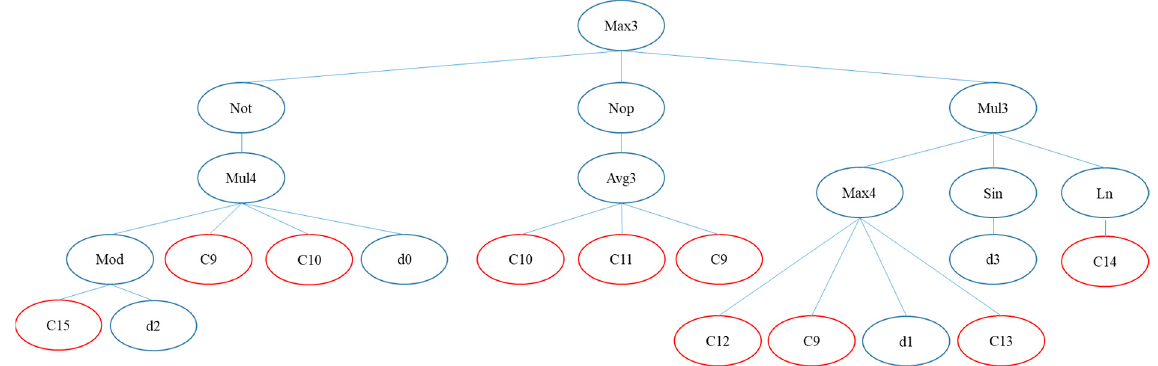
Figure A5. Sub-ET5 of GEP bathymetry retrieval model. Where, Avg is average function, Pow is power function, Nop is no operation, Min is minimize function, Max is maximize function, X3~5 is x to the power of 3~5, Floor is floor function, Pow10 is 10 to the power of x, Exp is exponential function, Atan is arctangent function, Mul is multiplication function, Div is division function, Add is addition function, Sub is subtraction function, Not is complement function, Mod is floating-point